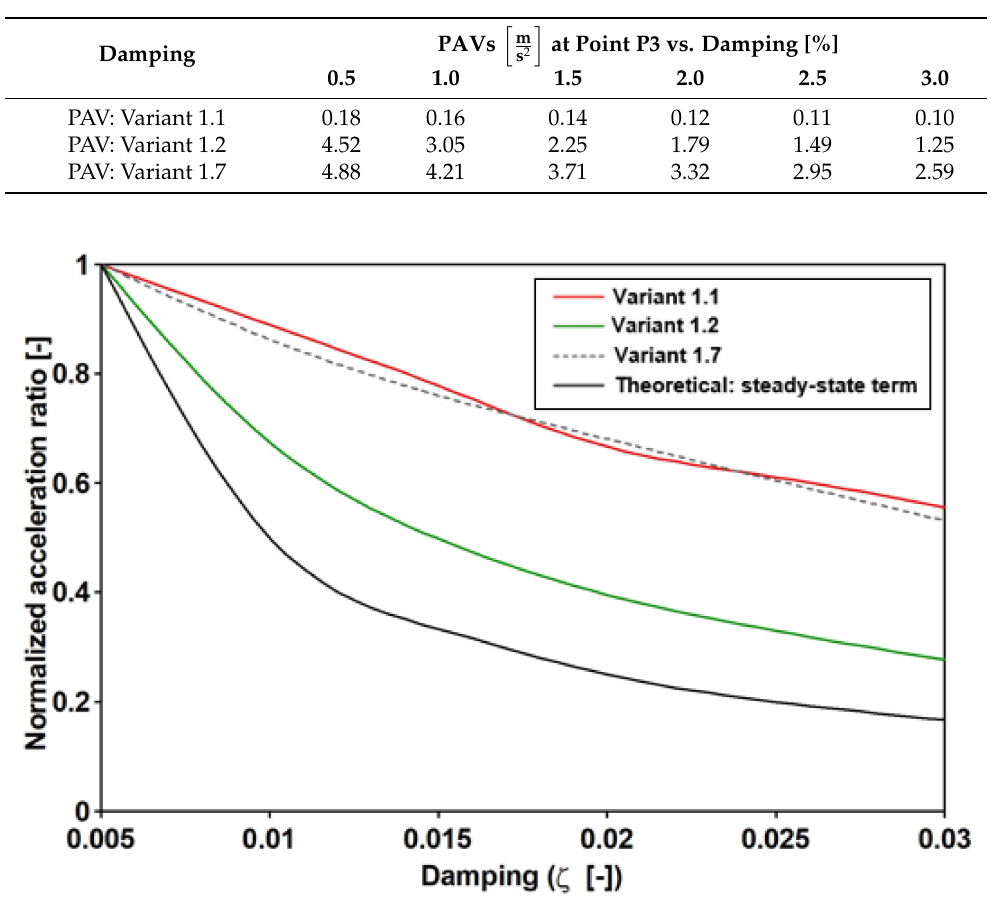
Figure 14. The sensitivity of the dynamic response vs. the damping of the footbridge for the lateral vibrations that are induced by walking (f 1 = 1.88 Hz), the vertical vibrations that are induced by walking (f 2 = 1.64 Hz) and the vertical vibrations that are induced by running (f 5 = 2.71